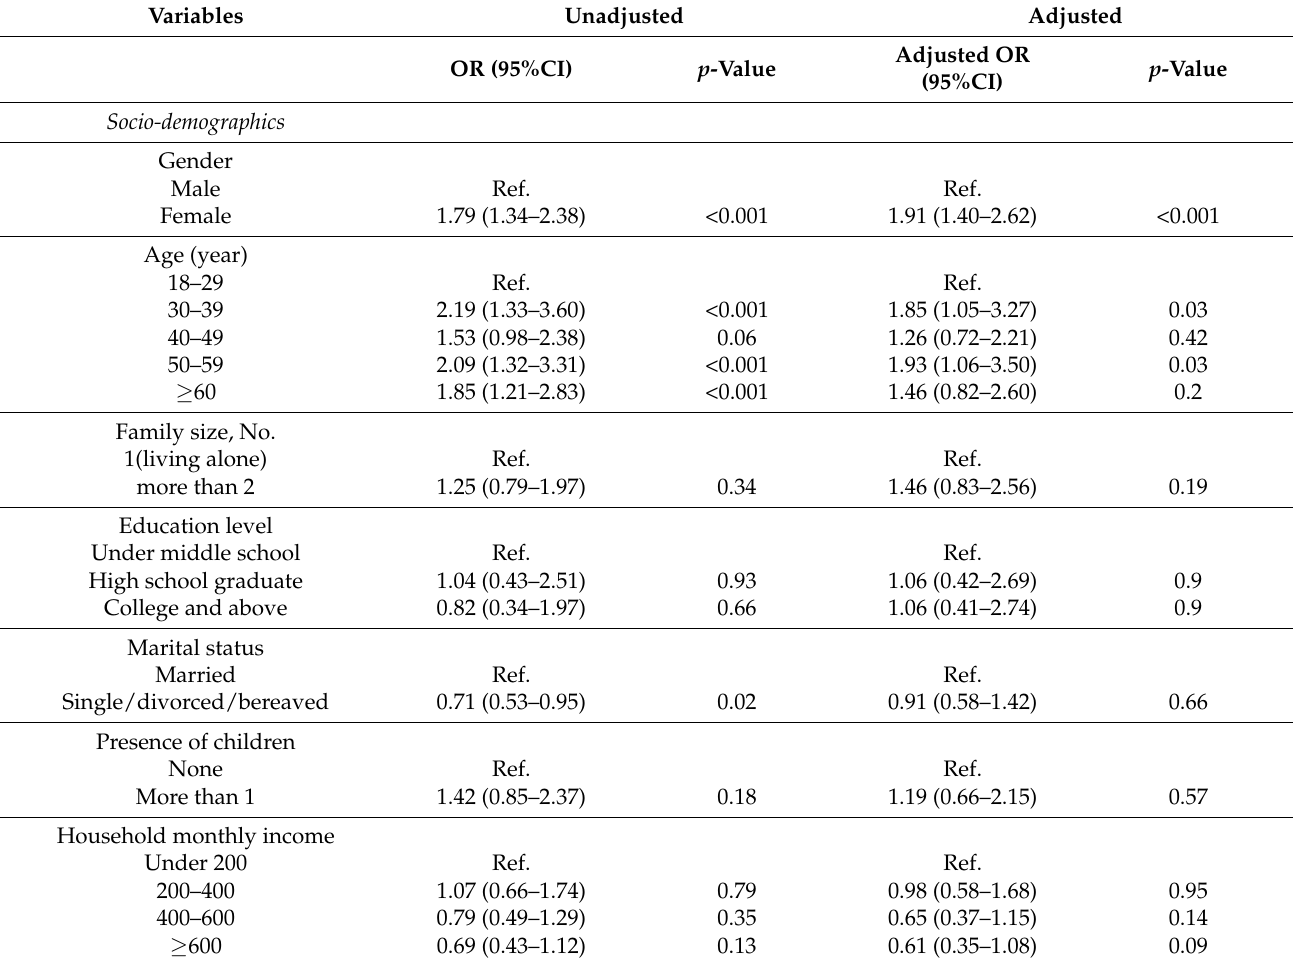
Table 3. Influencing factors associated with healthcare utilization avoidance ( n =